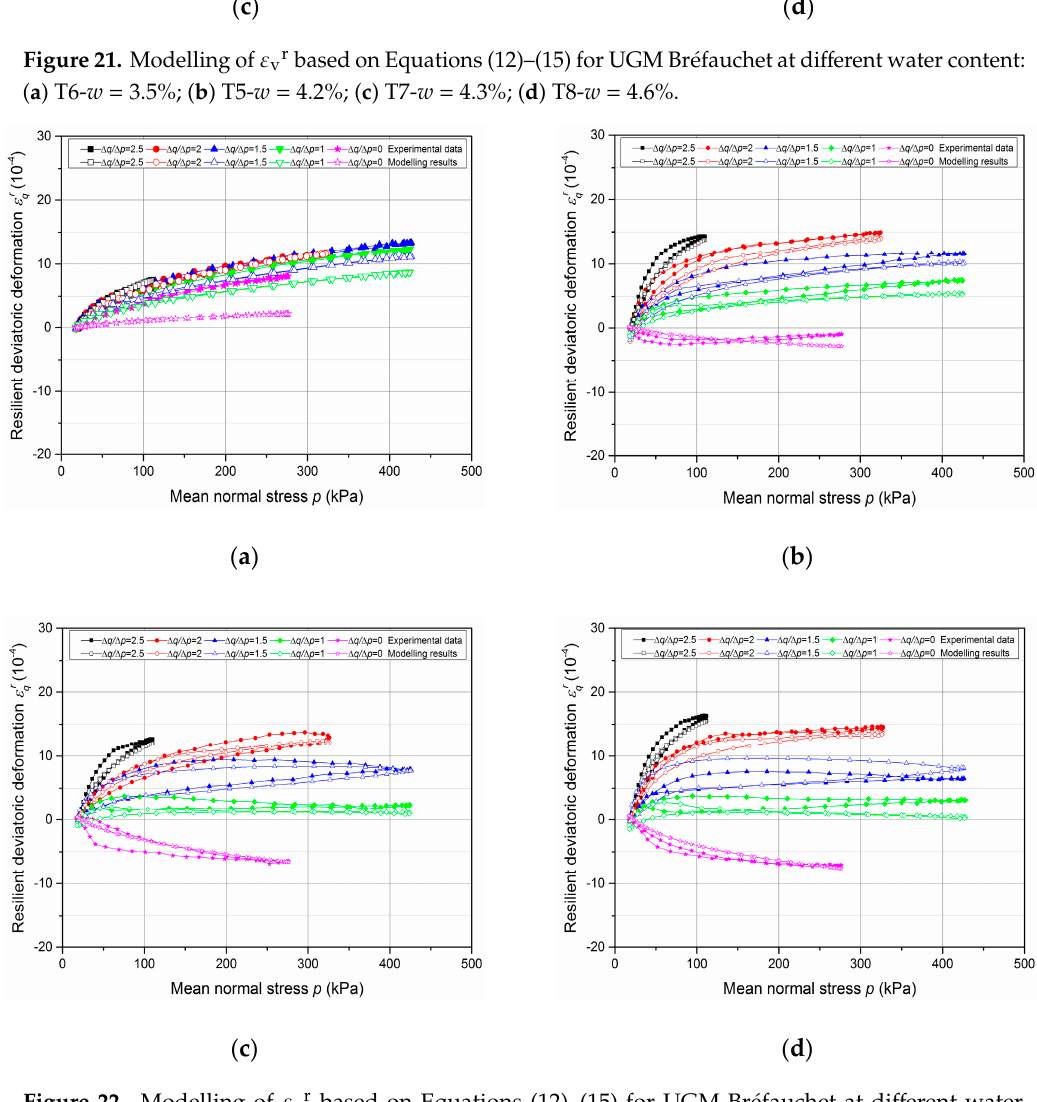
Figure 22. Modelling of ε qr based on Equations (12)–(15) for UGM Bréfauchet at different water